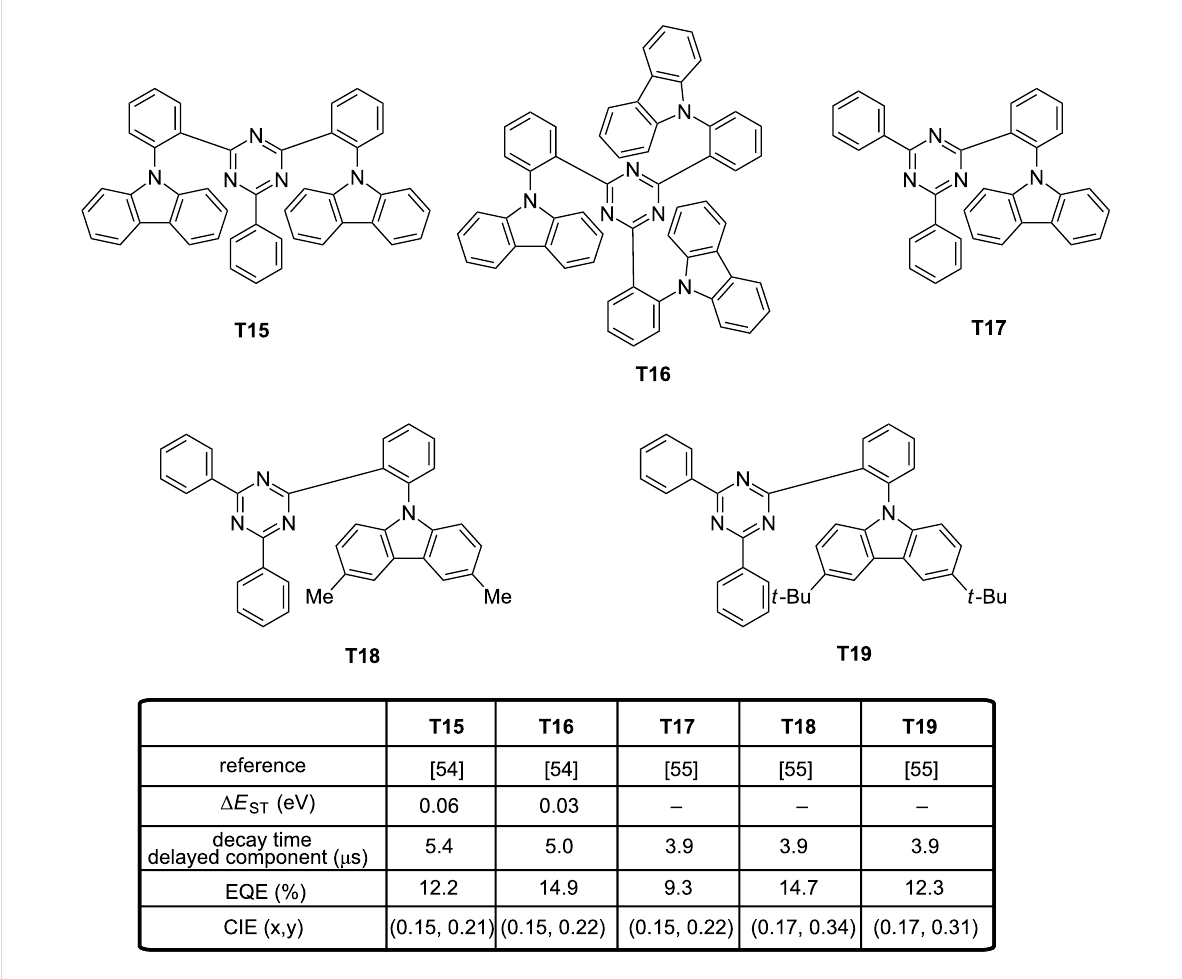
Figure 6: Triazine-based TADF emitters T15 – T19